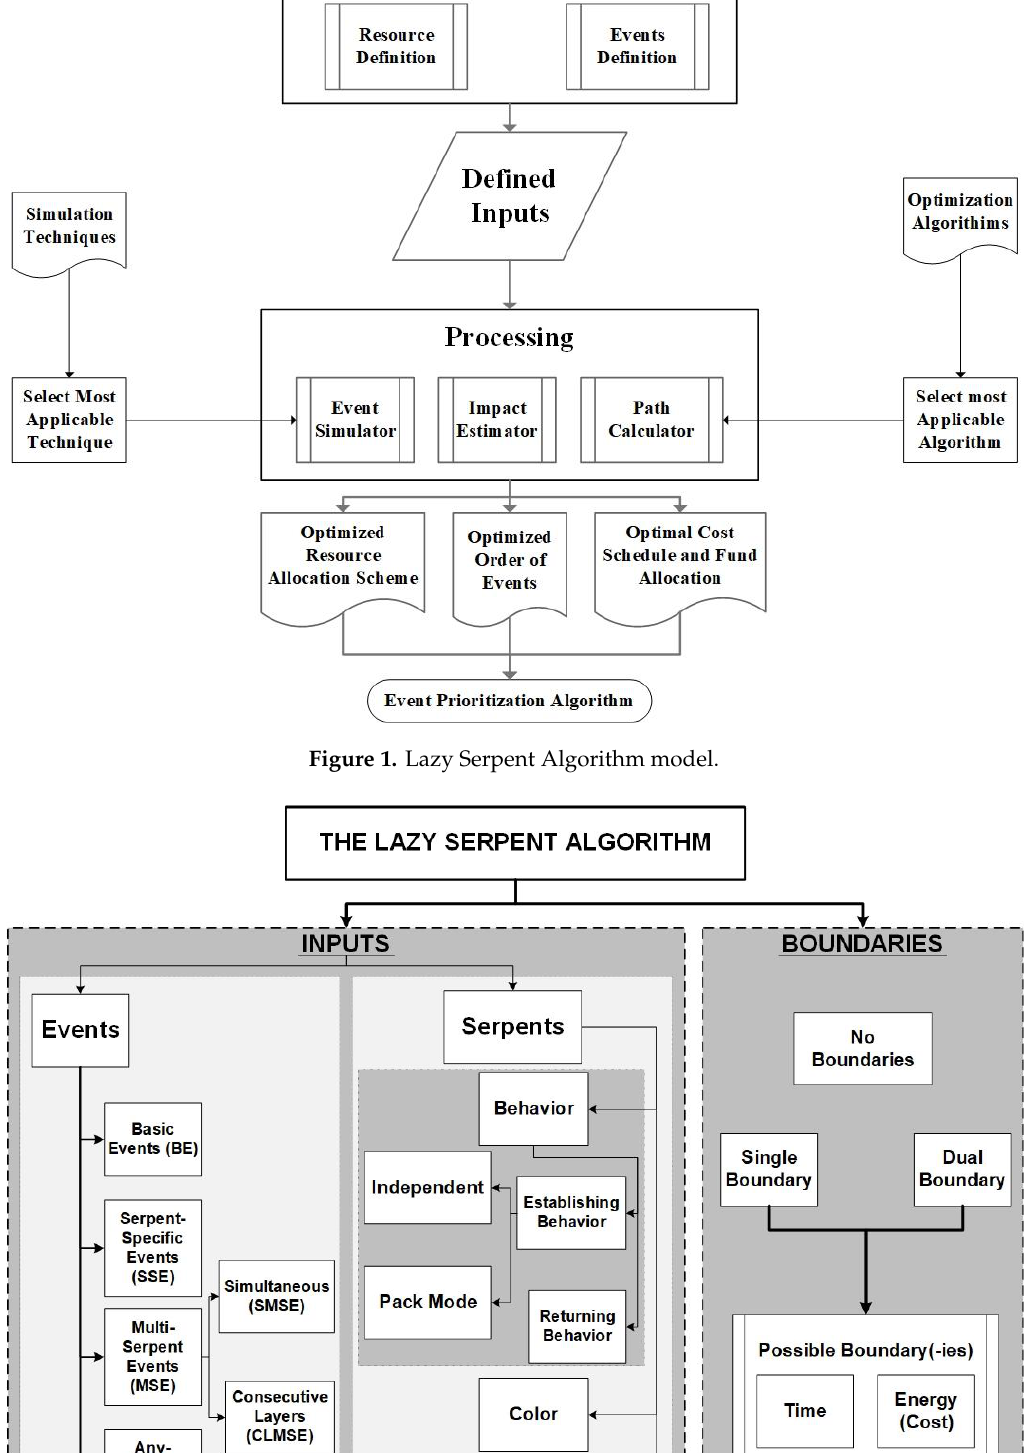
Figure 2. Lazy Serpent Algorithm components summary.